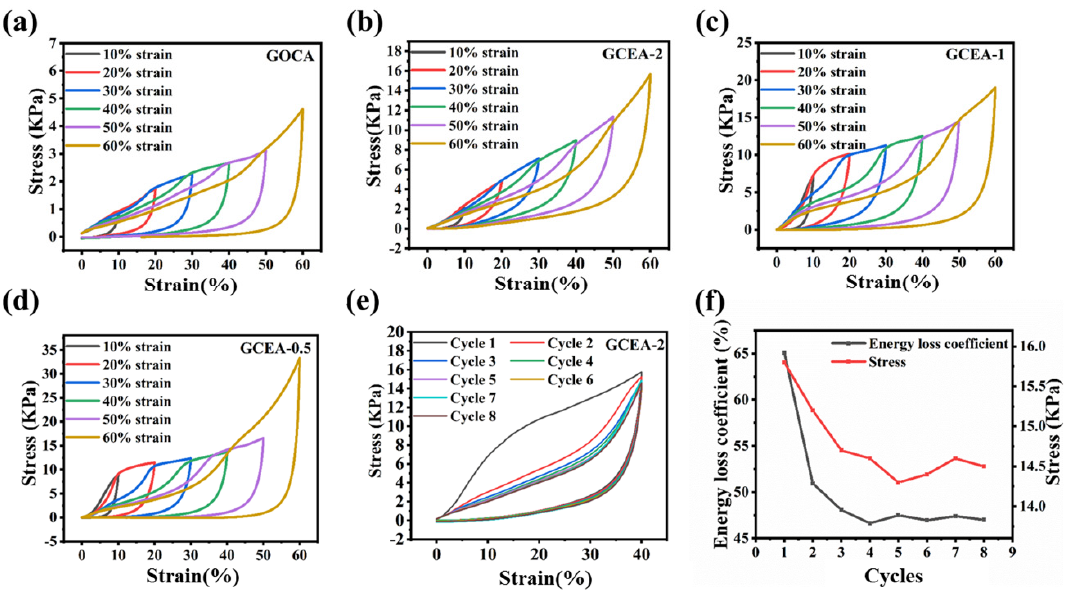
Figure 6. ( a – d ) The stress–strain curves of GOCA, GCEA aerogel at different maximum strains, ( e ) stress–strain curves of GCEA-2 at an extreme strain of 40% for 8 cycles, ( f ) energy loss coefficient and stress of carbon aerogels after repeated compression at a strain of 40% (Color figure can be viewed online).